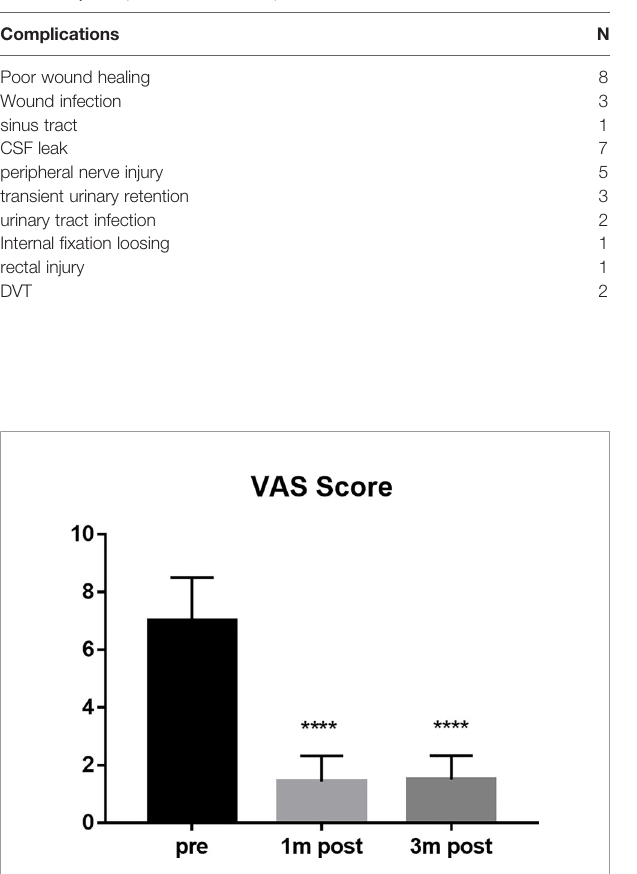
TABLE 4 | Complications of the 73 patients.